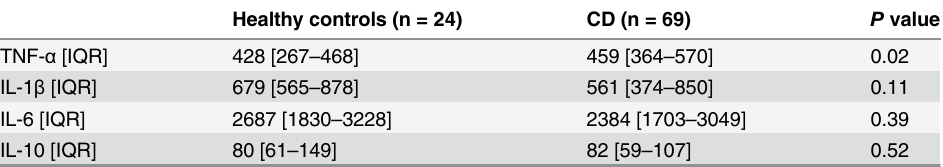
Cytokine levels (pg/ml) are presented as medians with the interquartile range [IQR]. TNF- α , Tumor necrosis factor alpha; IL, Interleukin; IQR, interquartile range; CD, Crohn's disease.